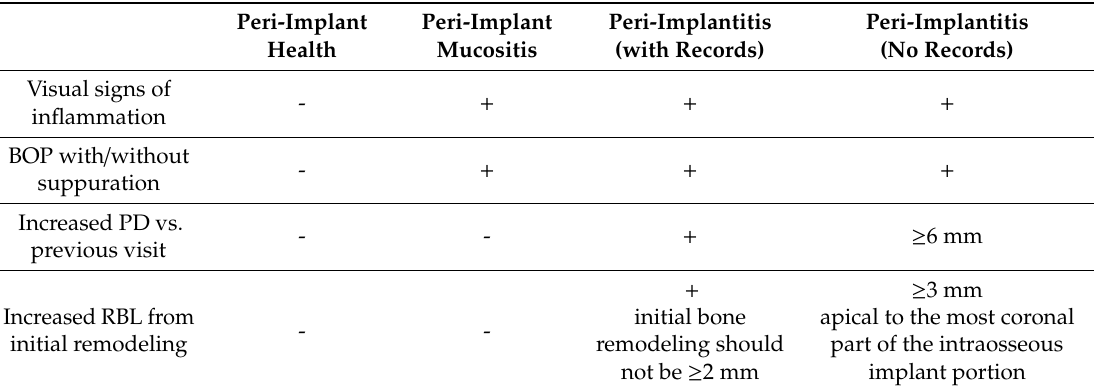
Table 1. Case definitions of peri-implant health and diseases according to the 2017 world workshop of the classification of periodontal and peri-implant diseases and conditions.